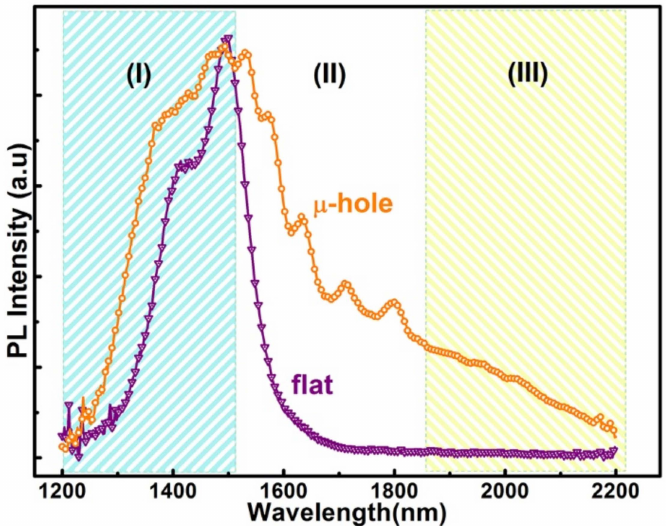
Figure 4. PL spectra. PL of graded Ge x Si 1 − x alloys on the micro-hole patterned and the flat Si(001) substrates, denoted by ‘ µ -hole’ and ‘flat’, respectively, at 17 K with the excitation power of 800 mW. (I), (II) and (III) denote three ranges of